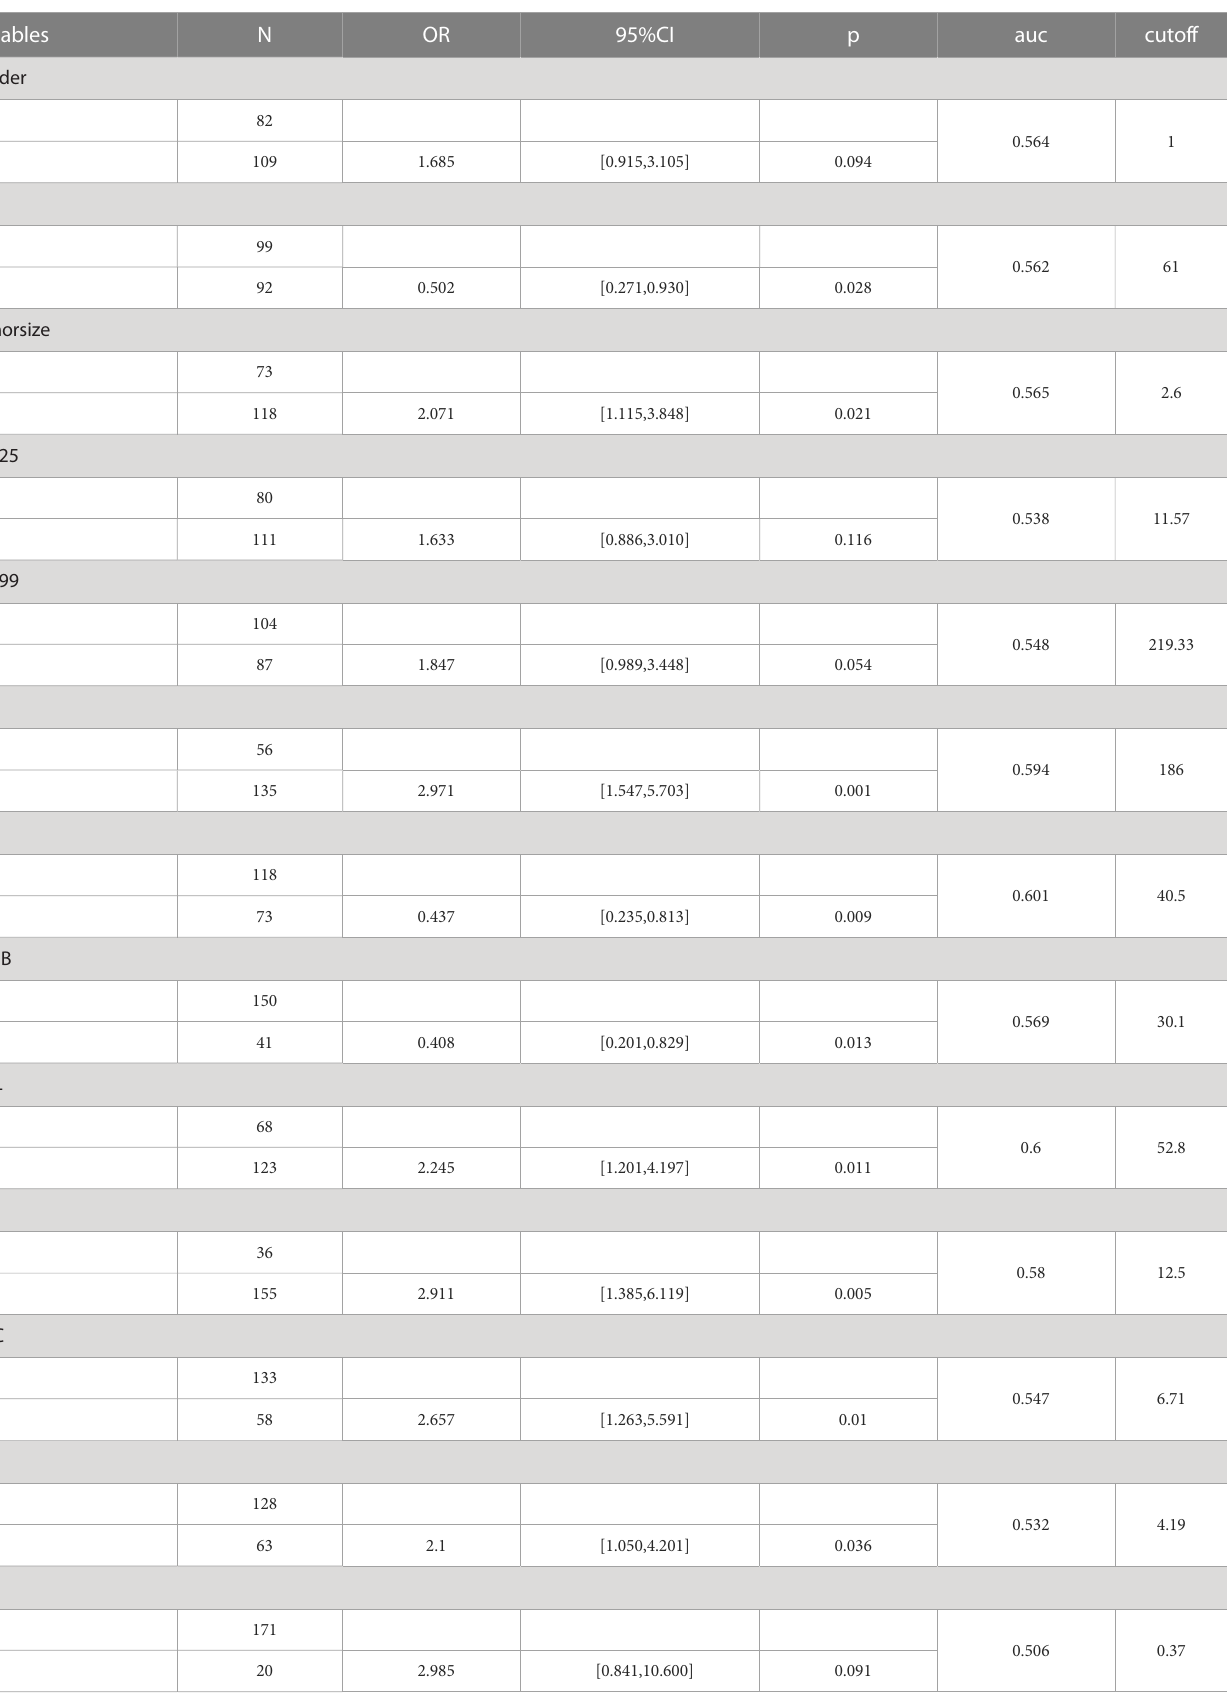
TABLE 2 Univariate regression